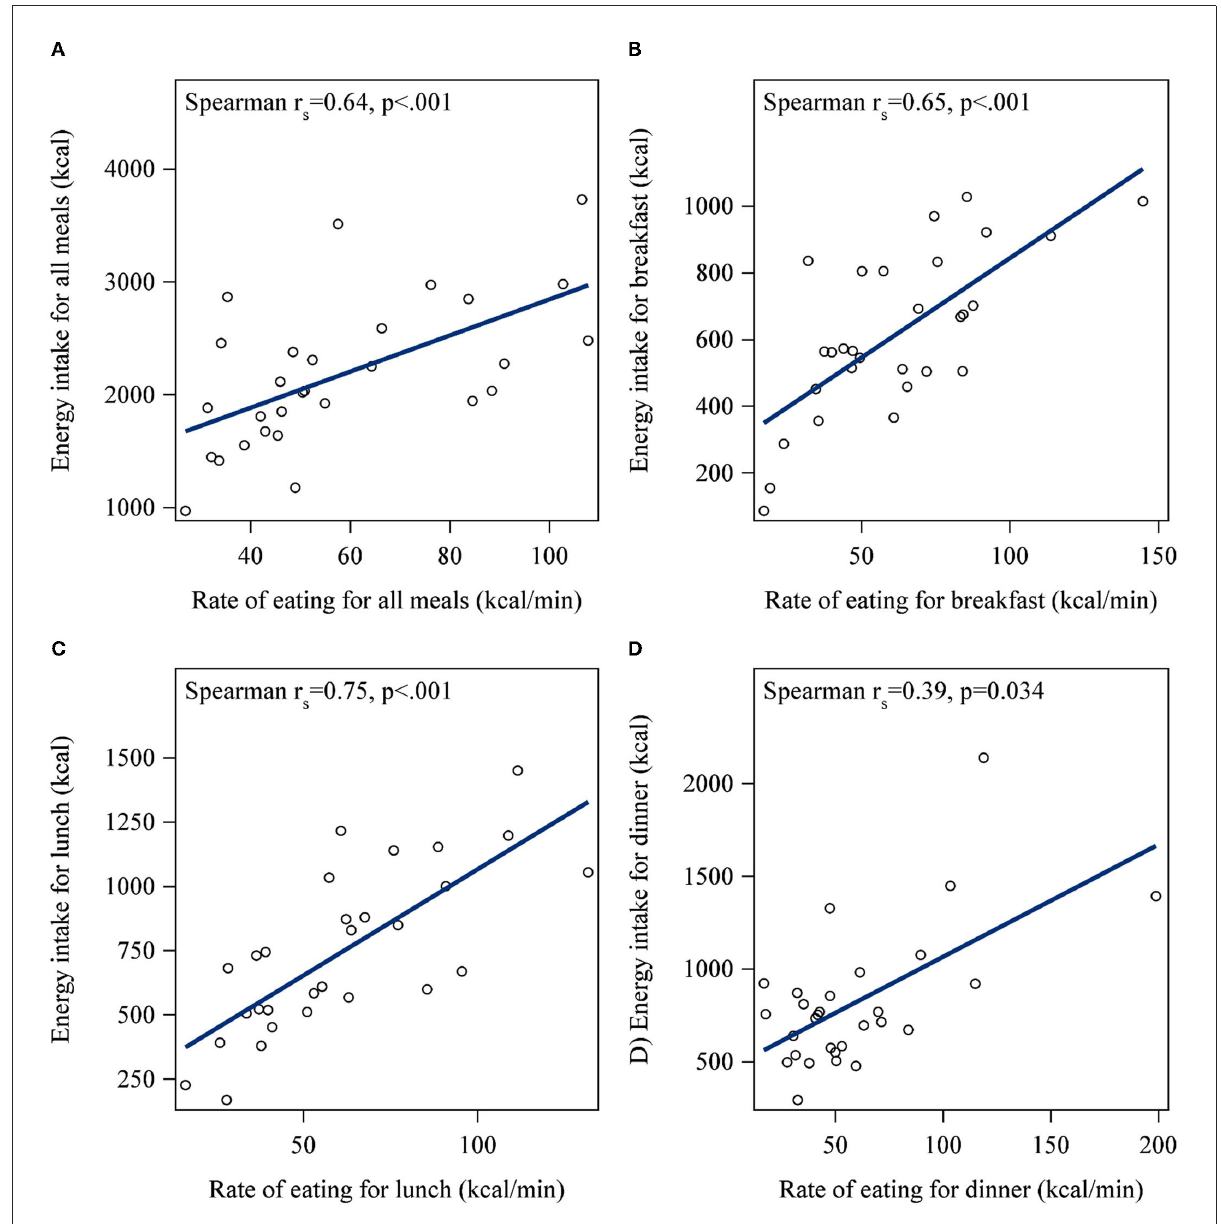
FIGURE2 Correlations between BMI and the rate of eating for (A) all meals, (B) breakfast, (C) lunch, and (D) dinner. A higher BMI was associated with the faster rate of eating at lunch (r s = 0.4; p = 0.03) but not breakfast, dinner, or the sum of all meals.